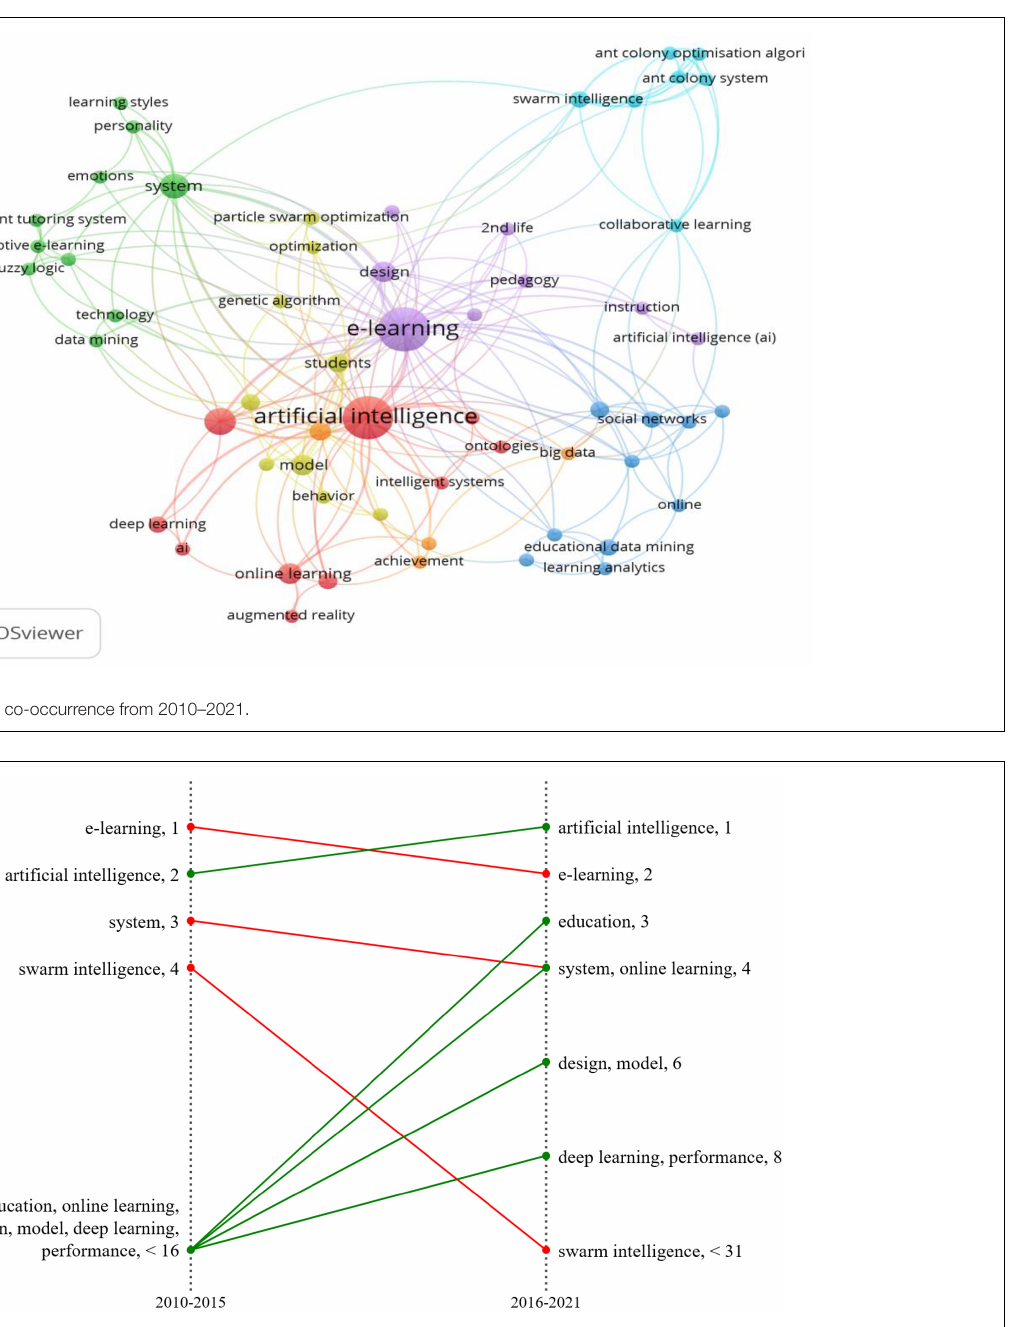
FIGURE 6 | Keyword evolution